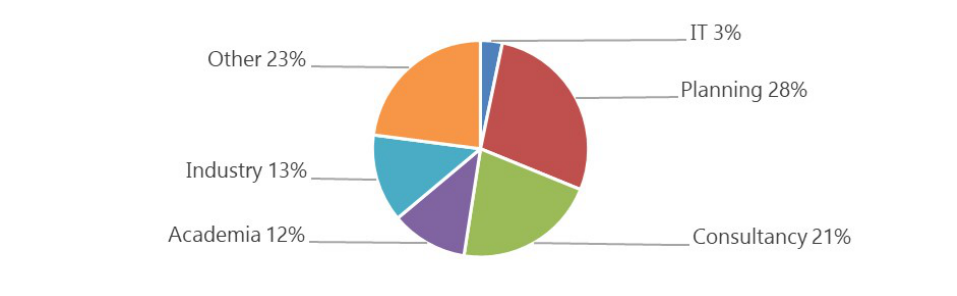
Figure 3. Survey results concerning past BST students’ professional foci after their